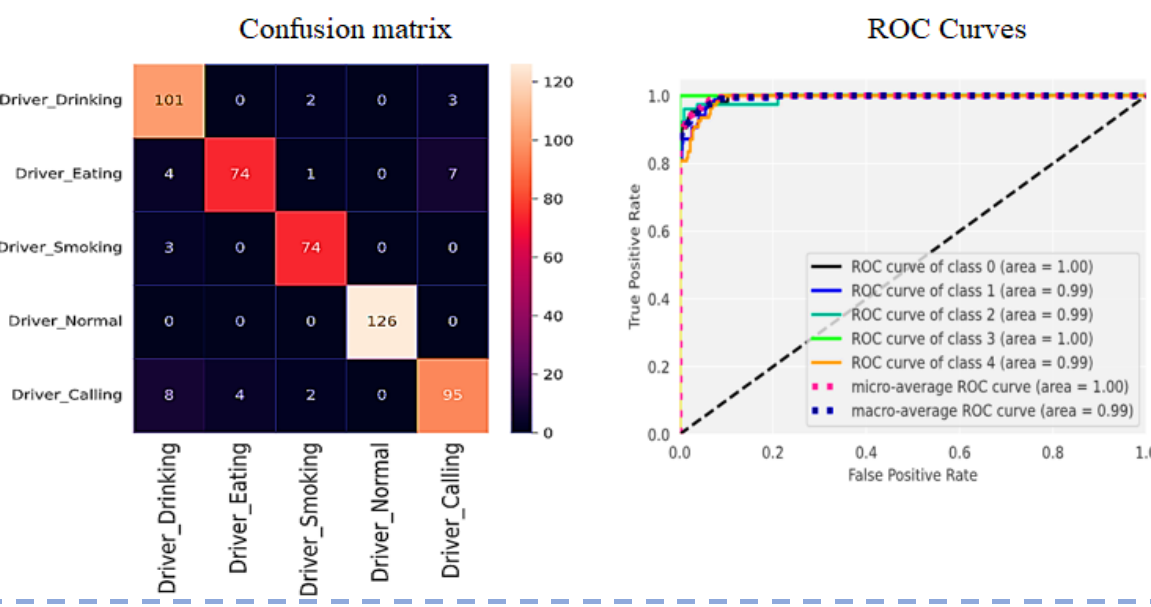
Figure 9. Confusion matrix and ROC Curves using VGG16.